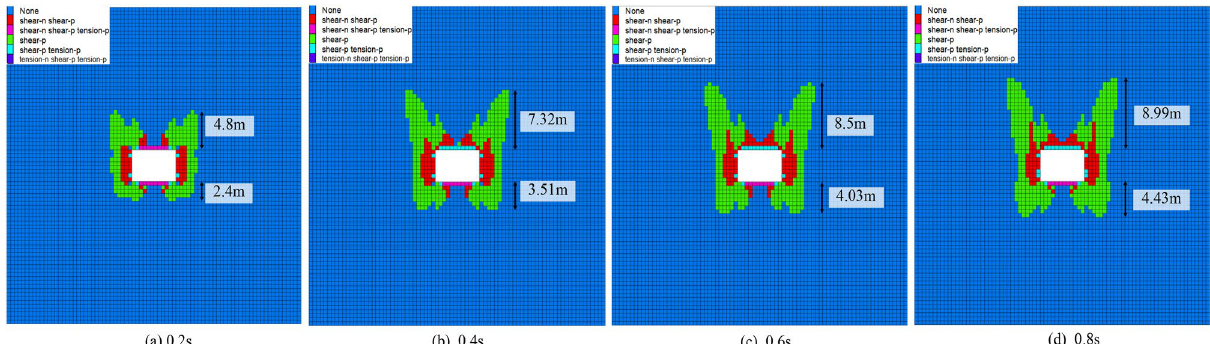
Figure 13. Failure of surrounding rock under different disturbance